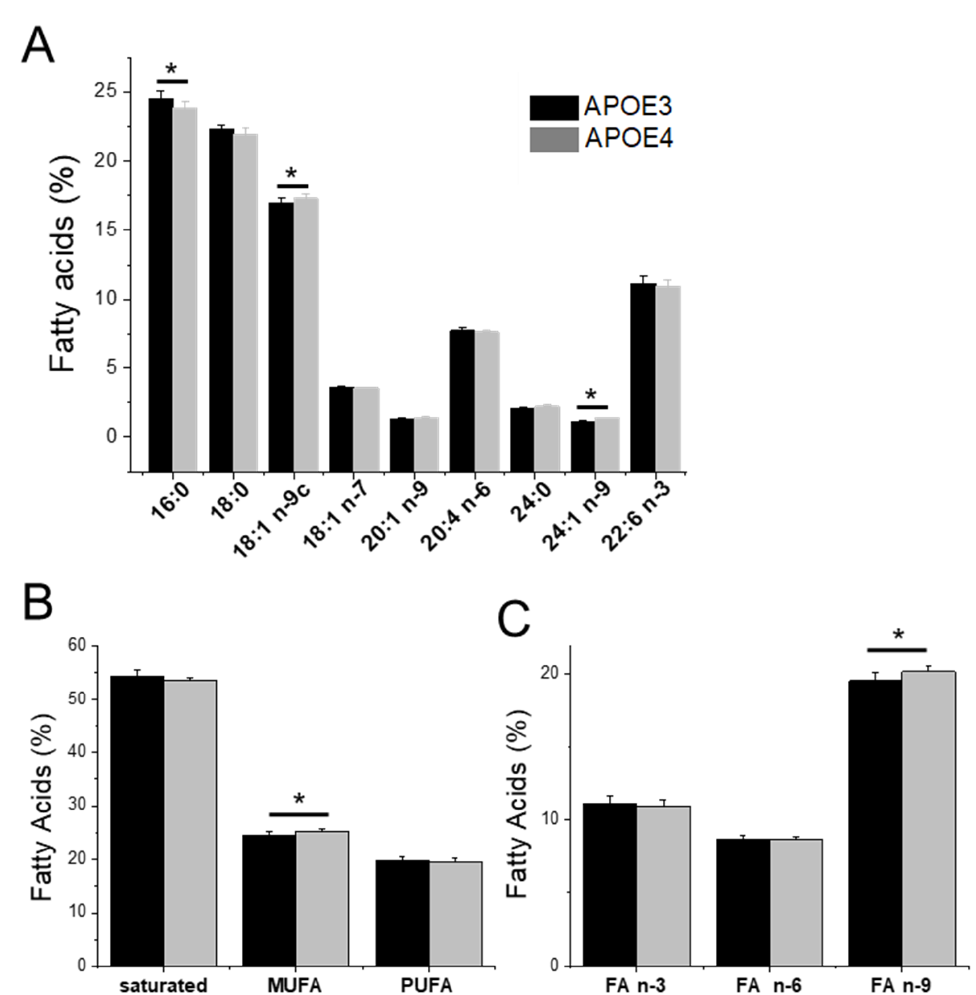
Figure 3. Fatty acids of the total lipid extract of APOE3 and APOE4 mice: ( A ) overview of the fatty acid composition; ( B ) level of fatty acids classified as a function of their degree of unsaturation; ( C ) proportion of unsaturated FA. Statistics: one-way ANOVA with Ficher’s correction *: p < 0.05.